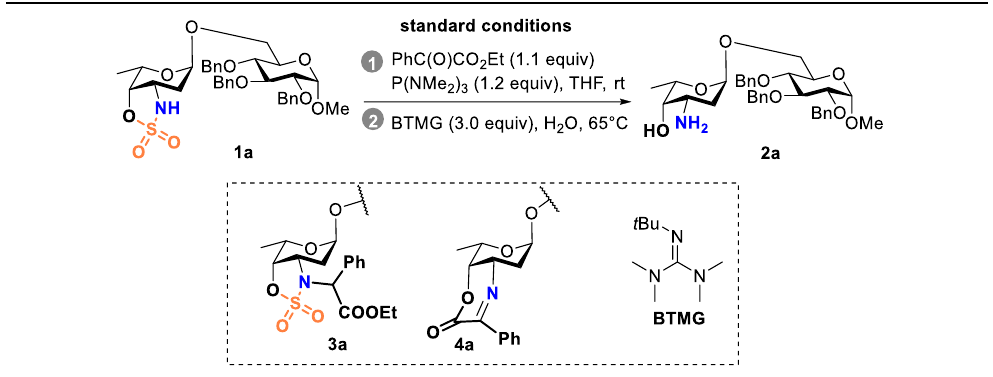
Table 1. Reaction development.